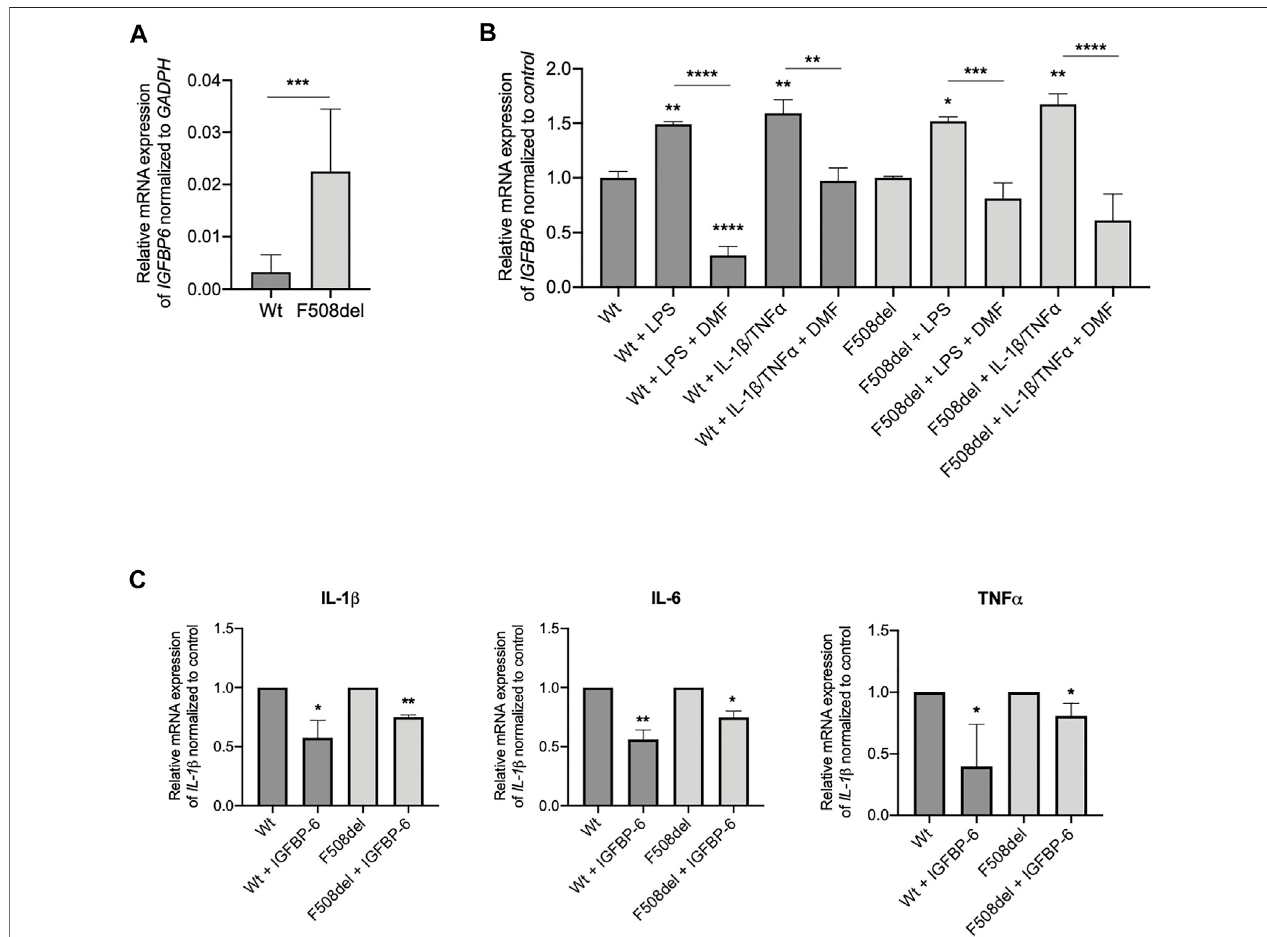
FIGURE4| IGFBP-6showshigherexpression in F508del / F508del nasalepithelialcellsfromthreeCFdonorsandreducespro-in fl ammatorycytokinesexpression. (A) Total RNA was extracted from 2 patients homozygous for F508del mutation and 2 non-CF donors. qRT-PCR was performed in order to quantify IGFBP-6 mRNA normalized toGADPH ashousekeeping gene. Data represent the mean ±SEM ( n = 4). Statistical signi fi cance tested using paired two-tailed t -test (B) Cells were treated with0.1%DMSO, 1 μ g/ml LPS,30 ng/mlIL-1 β +30 ng/mlTNF α ±50 µMDMFfor4 h.TotalRNAwasextracted andqRT-PCRwasperformedinordertoquantify IGFBP mRNA normalized to control untreated cells. Data represent the mean ± SEM ( n = 4). (C) Cells were treated with 200 ng/ml IGFBP-6 for 4 h. Total RNA was extracted and qRT-PCR was performed in order to quantify IL-1 β , IL-6 and TNF α mRNAs normalized to control untreated cells. Data represent the mean ± SEM ( n = 4). * p < 0.05; ** p < 0.01; *** p < 0.001; **** p < 0.0001. Statistical signi fi cance tested using two-way ANOVA with Tukey ’ s multiple comparisons test to the control for (Wt or F508del) each cell